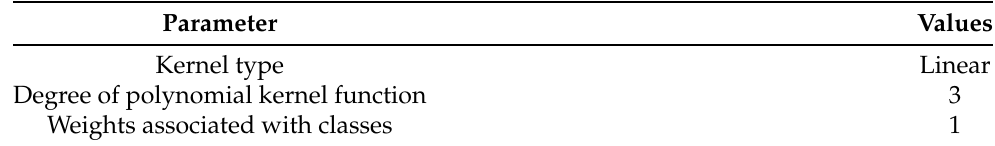
Table A3. Parameters of the support vector machines classifiers.